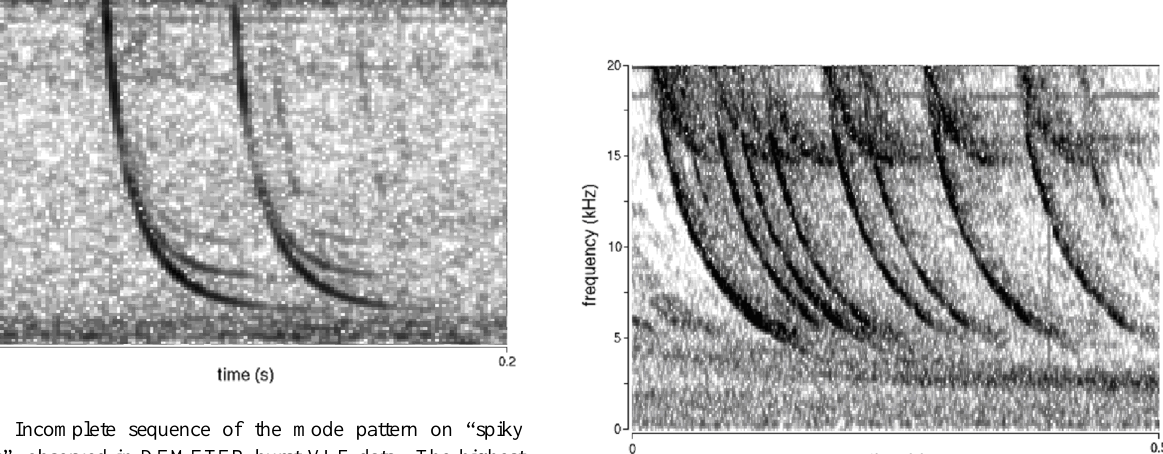
Fig. 3. Incomplete sequence of the mode pattern on “spiky whistlers”, observed in DEMETER burst VLF data. The highest observable harmonic is the 3rd. Noteworthy that the zeroth-order, basic mode is also missing in this example (orbit: 683 up, sen- sor: E34, date: 18 August 2004, 10:36:38.8 UT, satellite position: 33.3S; 179.7E, altitude: 734.2, L: 1.78).